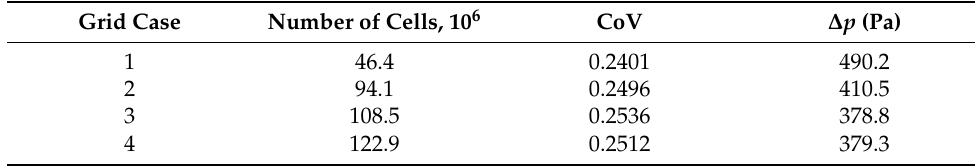
Table 1. Simulation results for different grid cases.